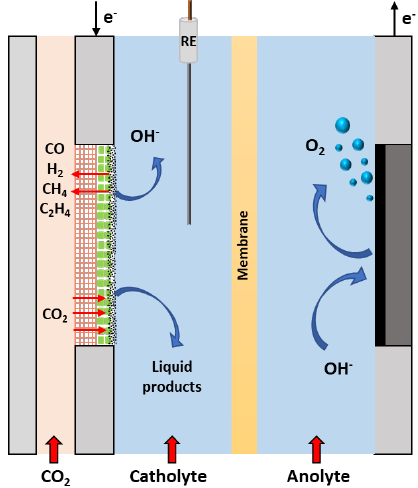
Figure 5. Schematic diagram of a basic gas-fed flow electrolyser. A gas diffusion electrode is used as a cathode, a traditional solid non-porous electrode is used as an anode, with an ion-exchange membrane separating the cathodic and anodic compartments. The catalyst layer on the gas diffusion electrode is in contact with the catholyte. A reference electrode is also present in the cathodic side.